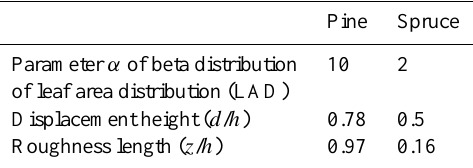
Table 1. Canopy parameters for pine and spruce.